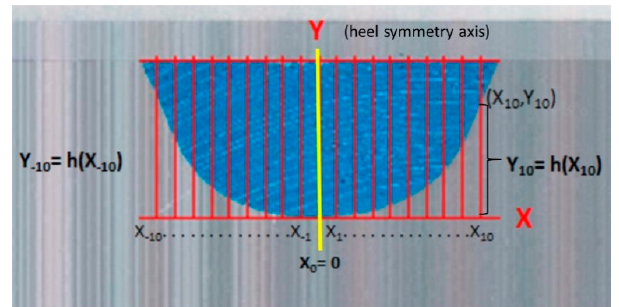
Figure 5. Processing for the measurements of the distinct points of the curve and to determine its symmetry index. 10 coordinates were estimated in each half heel from − 10 to +10, beside symmetry “Y” axis (yellow line). For example: (X10, Y10) coordinates were determined measuring the distance of X10 on X axis, and the high of Y10 (h(X10)) on Y axis. For each foot, 20 coordinates were determined, 10 in each half of the heel. The sum of this coordinates is included in the equation.